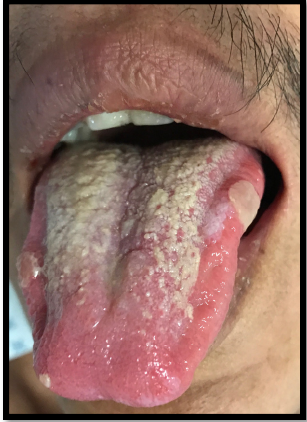
Figure 10. Major aphthous ulcers on the lateral borders of the tongue and coated tongue.